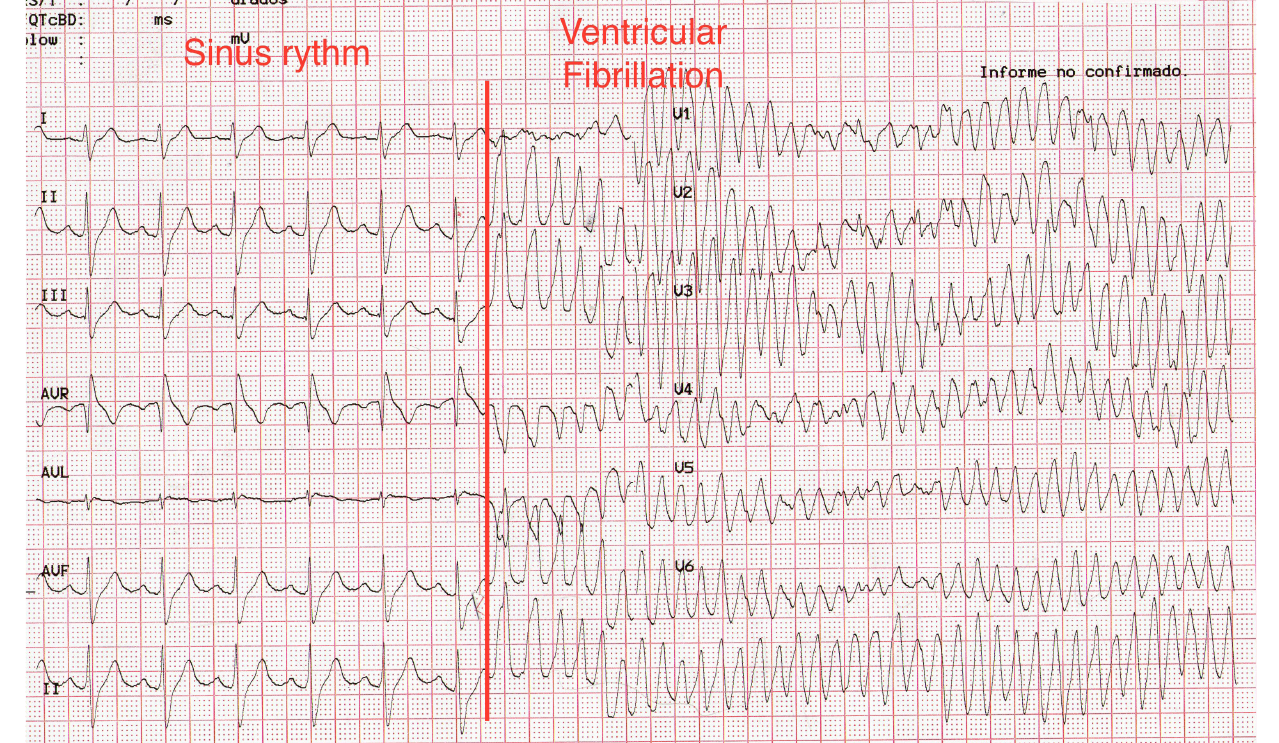
Figure 1. Twelve-lead electrocardiogram showing the degeneration from sinus rhythm to ventricular